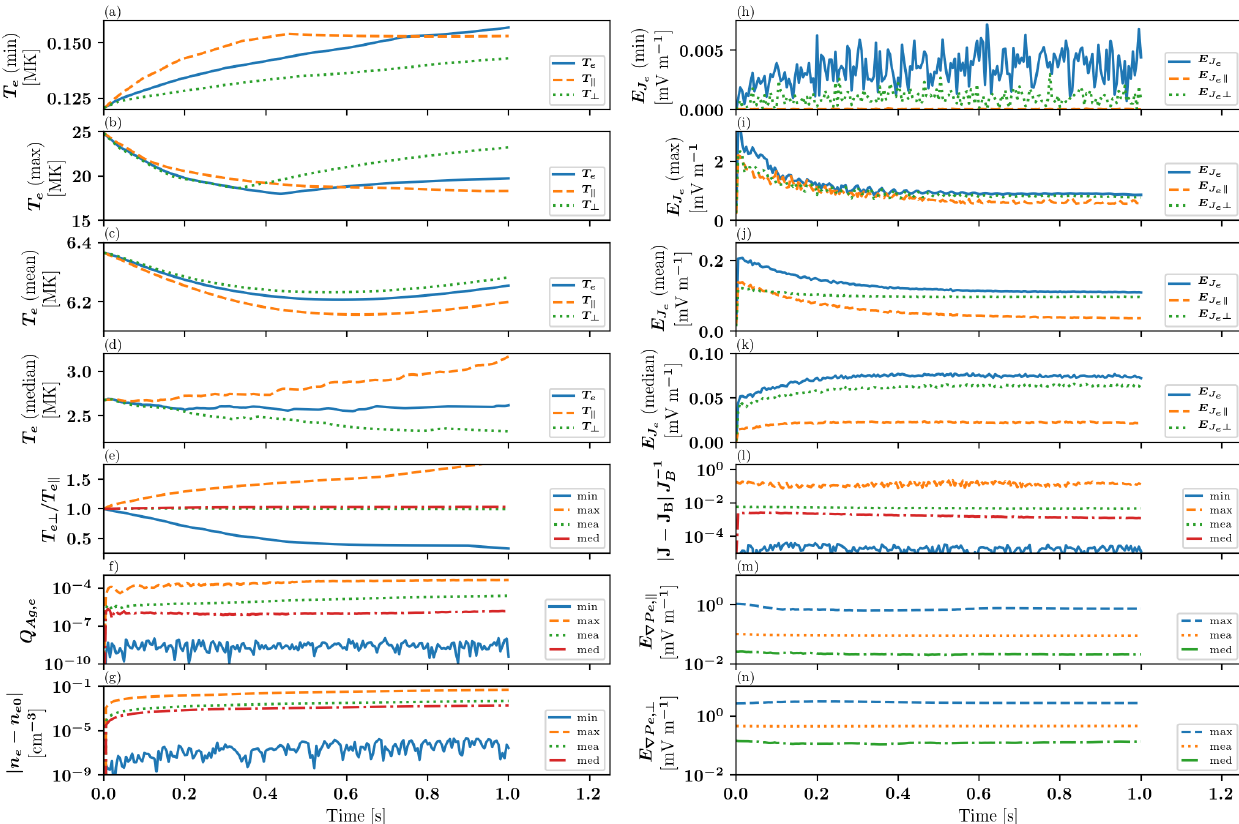
Figure 5. Evolution of electron and solver parameters over the whole simulation domain. ( a – d ) Minimum, maximum, mean, and median values for electron temperature T e and its components parallel and perpendicular to the local magnetic field. (e) Minimum, maximum, mean, and median values for electron temperature anisotropy. (f) Minimum, maximum, mean, and median values for electron agyrotropy Q Ag , e . (g) Minimum, maximum, mean, and median values for electron density deviation from initial state, indicating charge imbalance. (h– k) Minimum, maximum, mean, and median values for the plasma oscillation electric field E J and its components parallel and perpendicular e to the local magnetic field. (l) Minimum, maximum, mean, and median normalized values for current density J deviation from the value J B = ∇× B required to fulfill Ampère’s law for the local magnetic field. (m, n) Maximum, mean, and median values for parallel and µ 0 perpendicular components of the electric field due to electron pressure